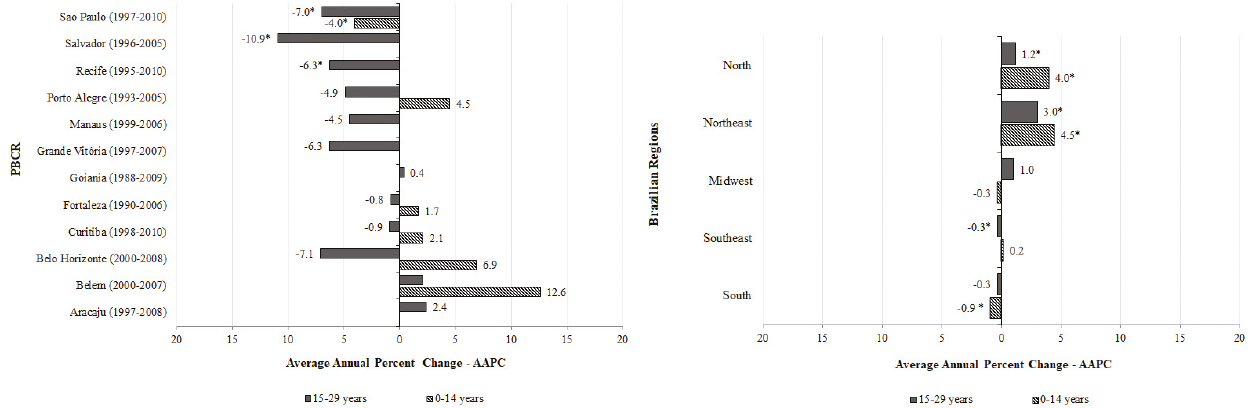
Figure 2 – Joinpoint regression analysis of incidence and mortality trends by bone tumors in children, adolescents and young adults (0-29 years) in Brazil, according to PBCR and Brazilian